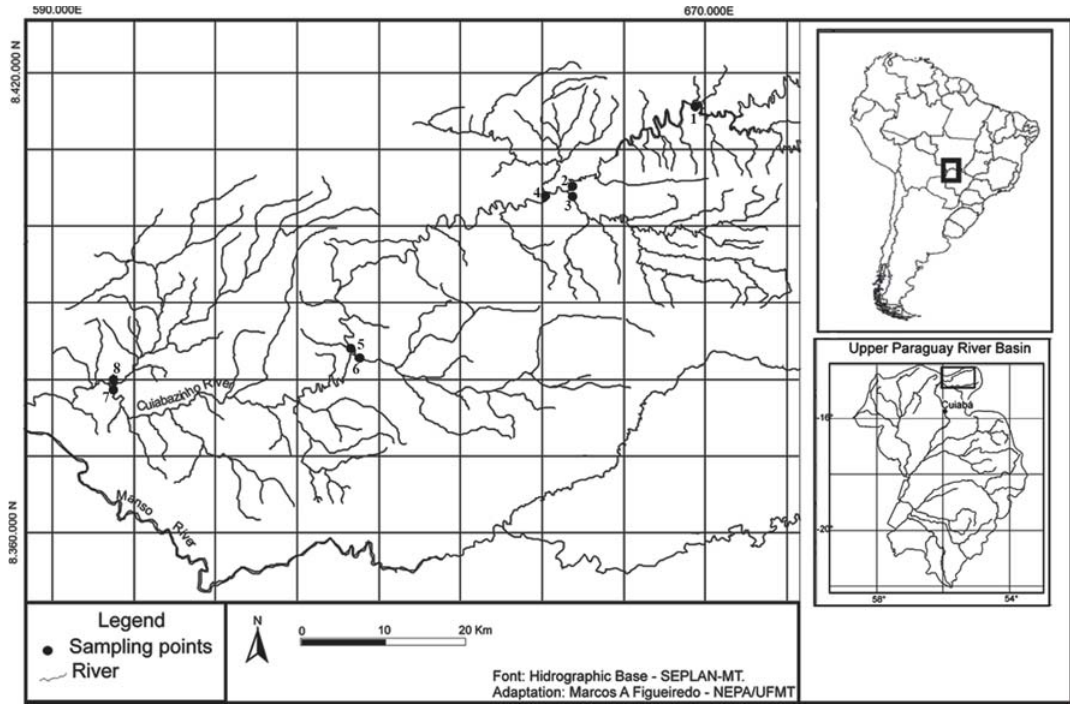
Fig. 1. Location of the sampling sites. 1= Cuiabazinho River (CBZ I, 14º20’13.8”S 55º29’42.5”W); 2= Cuiabazinho River (CBZ II, 14º25’39.1”S 55º34’28.8”W); 3= Água Fina Stream (AFS, 14º25’50.7”S 55º34’14.5”W); 4= Cuiabazinho Stream (CBS, 14º26’13.8”S 55º36’03.2”W); 5= Cuiabazinho River (CBZ III, 14º37’10.1”S 55º49’50.8”W), 6= Triste Stream (TRS, 14º37’18.2”S 55º49’52.2”W); 7= Cuiabazinho River (CBZ IV, 14º39’15.8”S 56º07’52.2”W); 8= Quebó Stream (QBS, 14º39’14.9”S